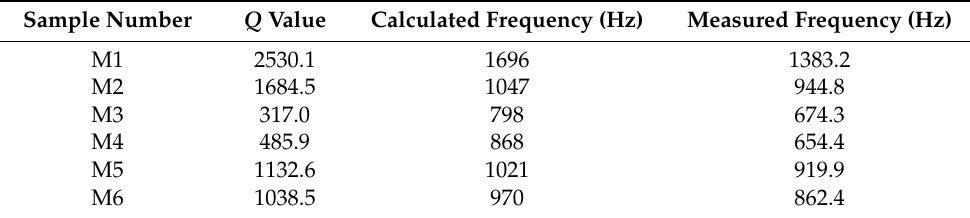
Figure 9. Comparison of the sensitivity in orthogonal axes. Table 3. Measured and calculated resonance frequency of different magnetometer samples.